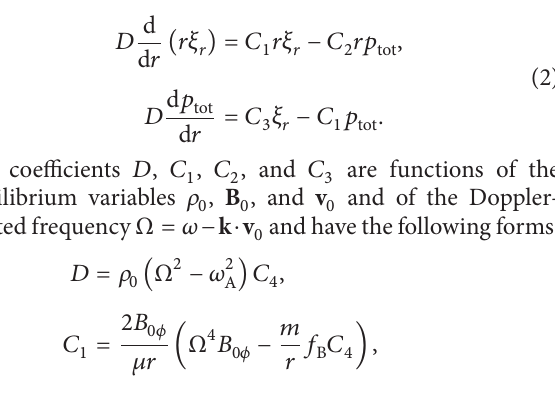
uniform and directed along the tube axis, B e = (0, 0, 𝐵 e ) .